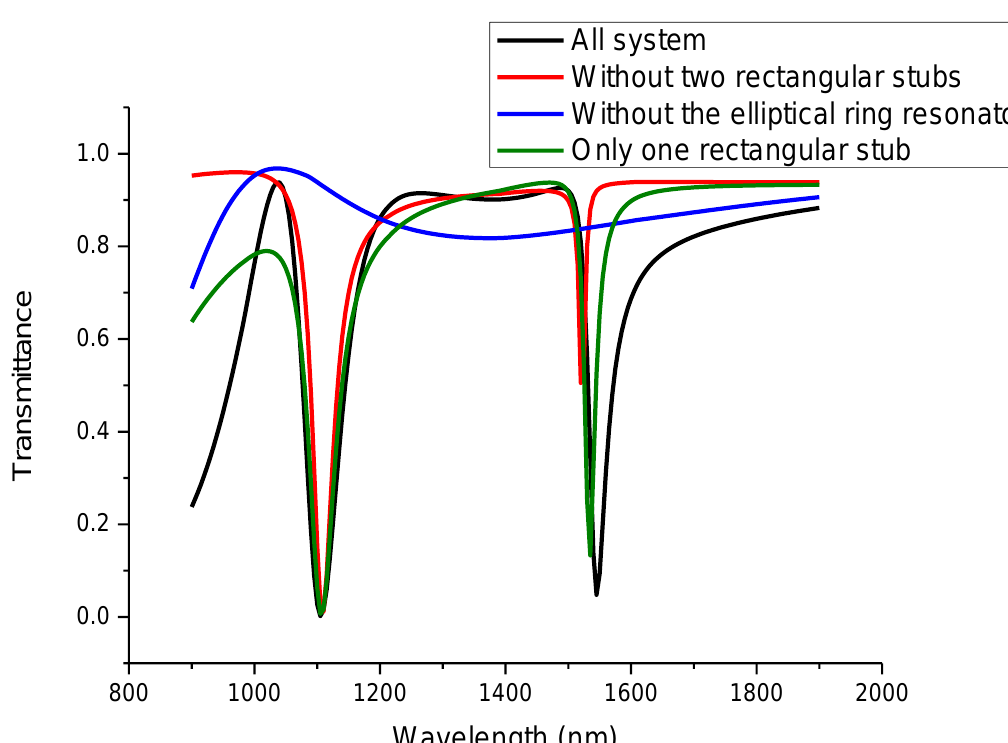
Figure 2. Transmission spectrum of the whole system (the black line), without two rectangular stubs (the red line), without the elliptical ring resonator (the blue line), with only one rectangular stub (the green line) when R 1 = 300 nm, R 2 = 140 nm, r 1 = 150 nm, r 2 = 70 nm, d = 10 nm, l = 480 nm, h = 60 nm .